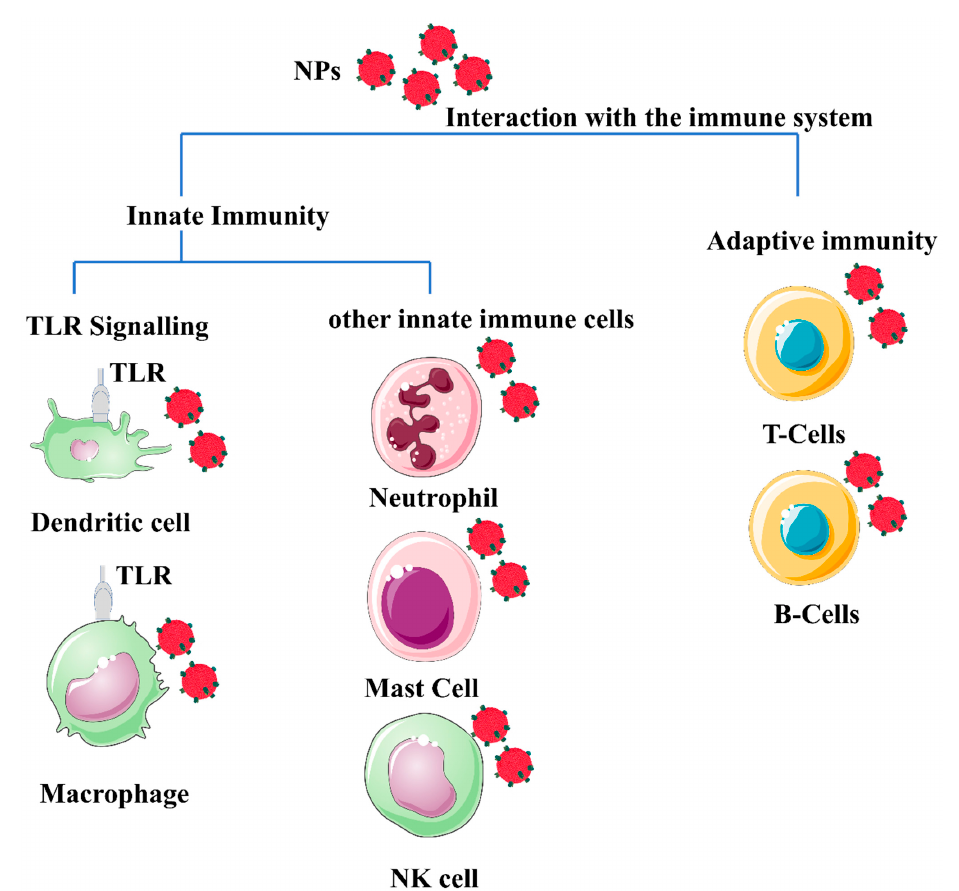
Figure 1. Schematic illustration of a generic form of nanomaterials (polymeric or metal-based) depicted in red spheres, showing their potential interaction with different immune system cells. The different properties of nanoparticles (NP) properties, such as morphology, size, surface charge, and composition, influence the interaction with immune cells. Most NPs induce an innate immune re- sponse. Mature innate immune cells such as lymphocytes, dendritic cells, monocytes, mast cells, neutrophils, macrophages, and natural killer cells, as well as pattern recognition receptors such as toll-like receptors (TLRs). In addition, nanomaterials’ interaction with the adaptive immune system activates Th1/Th2 responses and stimulates the production of cytokines. The effect of nanomaterials on B cells appears to enhance immunity during vaccination, and B cells are normally targeted by specifically functionalized nanomaterials to target B cells with lymphoma to kill lymphoma and generate a chemotherapeutic effect from the use of the NPs. The image was generated by BioRender. Once a nanomaterial is designed for use in vivo, three immune-related effects should be considered. The first is degradation or rejection through the immune system, which may result in a protective immune response. The second point is immunotoxicity, which could damage and trigger inflammatory and pathological changes in the immune system. Third, immune compatibilities do not affect the immune response [3,13].